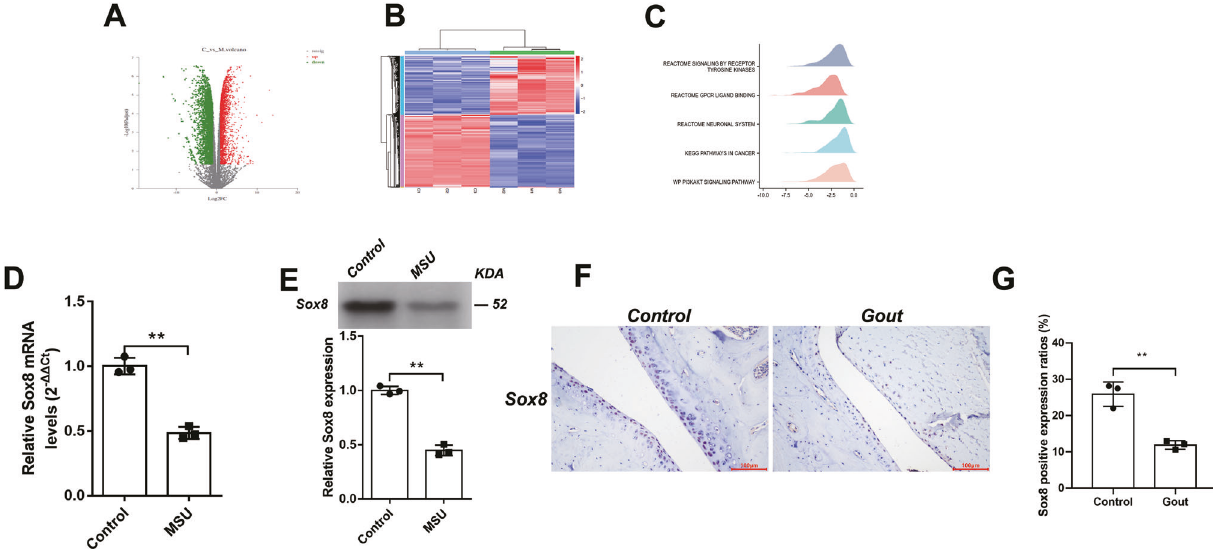
Fig. 1 The mRNA expression of Sox8 was signi fi cantly downregulated in gouty arthritis rat models and MSU crystal-treated chondrocytes. Volcano plot ( A ) and heatmap ( B ) of the mRNA sequencing result of cartilage from control group and gouty arthritis models. In the volcano plot, the green ones stand for downregulated genes and the red ones for upregulated genes; C and M in plots stands for control and model (gouty arthritis models) group respectively. In the heatmap, the blue ones represent downregulated genes and the red ones for upregulated genes. GSEA ( C ) illustrated the differentially identi fi ed genes. C28/I2 cells were incubated with MSU (200 μ g/mL) for 24h and Sox8 mRNA determined. The expression of Sox8 mRNA was signi fi cantly decreased both at mRNA level ( D ) and at protein level ( E ). The protein expression of Sox8 ( F and G ) in the cartilage of gouty arthritis rat models and the controls. Cartilage was stained with blue and Sox8 was stained